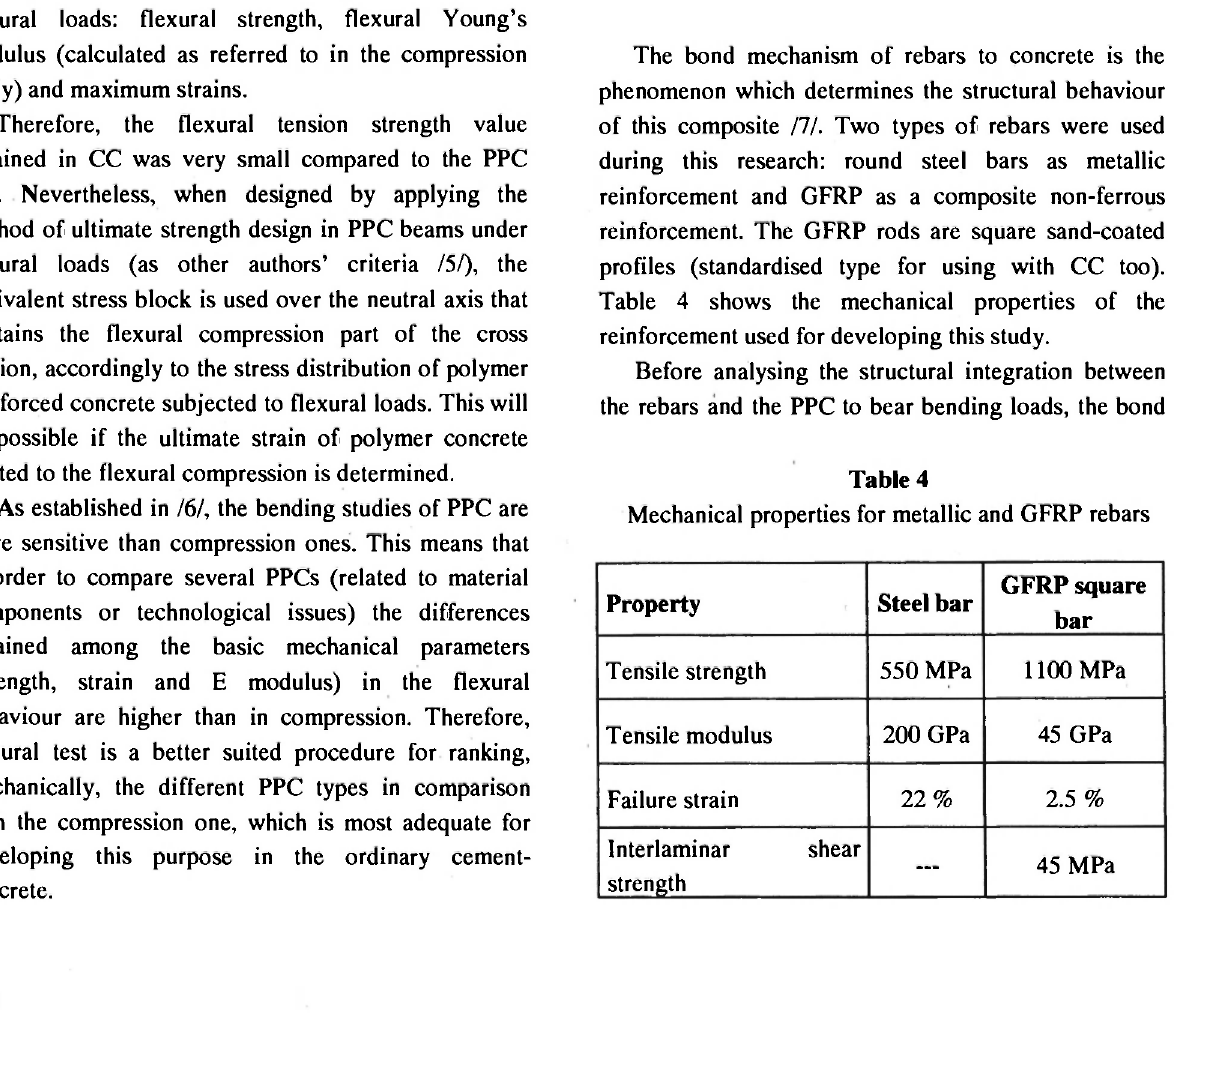
Fig. 4: Flexural stress vs strain curves in